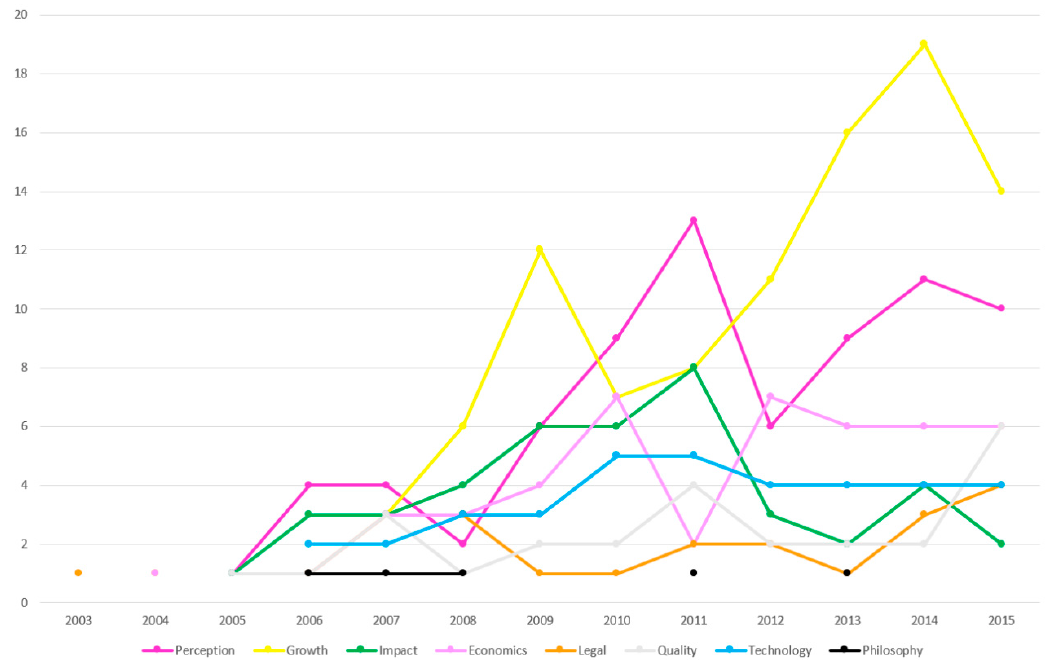
Figure 1. Evolution of the Open Access Themes in the International Scientific Literature.